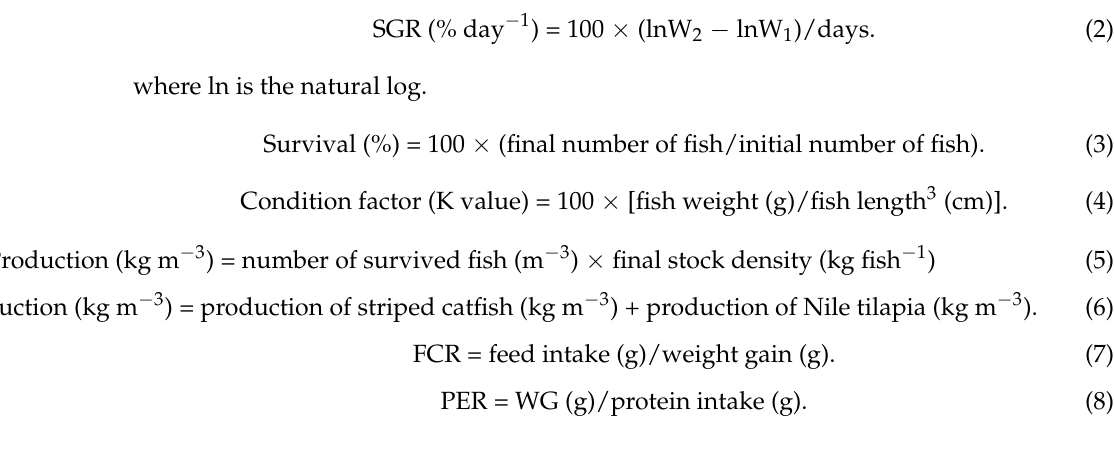
Table 1. Formulation and proximate composition of experimental diet (g kg − 1